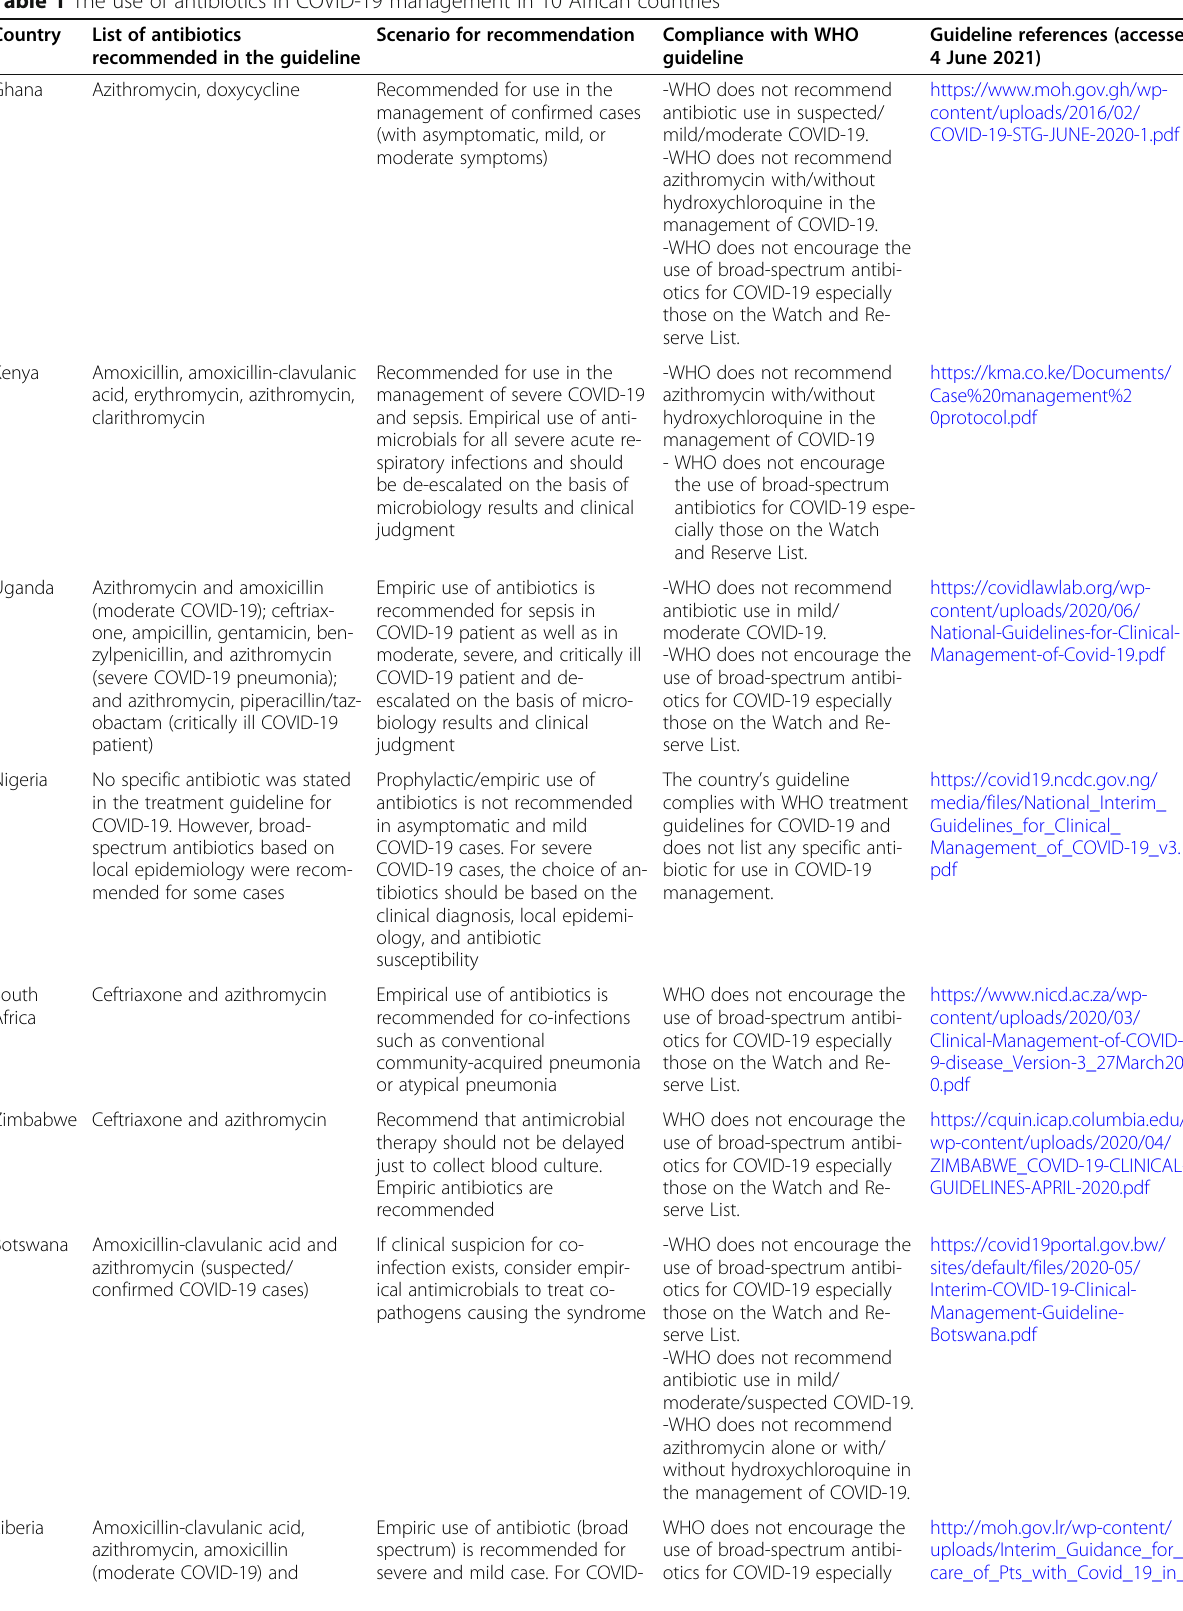
Table 1 The use of antibiotics in COVID-19 management in 10 African countries Country List of antibiotics Scenario for recommended in the guideline